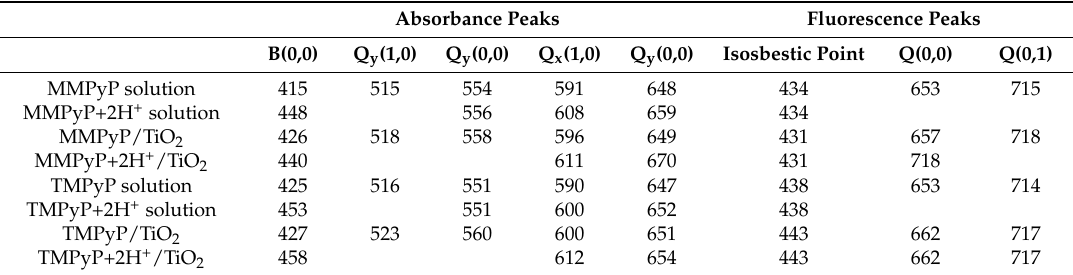
Table 1. Position of the main peaks and isosbestic points in the absorption and emission intensity spectra for MMPyP and TMPyP in solution and in TiO 2 films before and after protonation. Absorbance